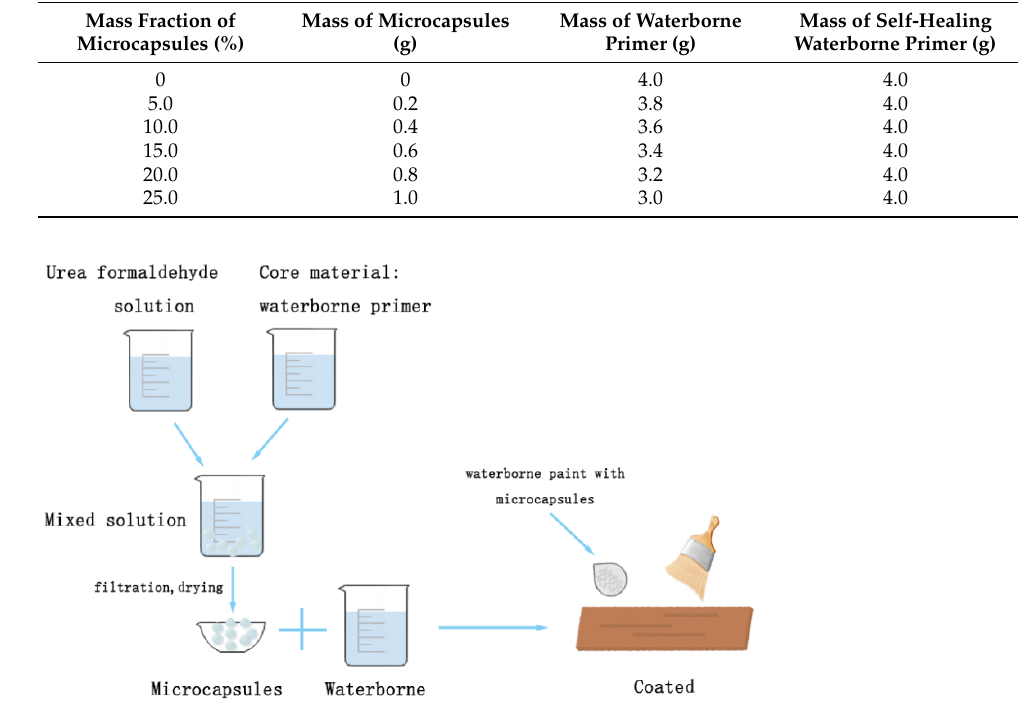
Table 2. Ingredients for the preparation of the waterborne primer coatings.